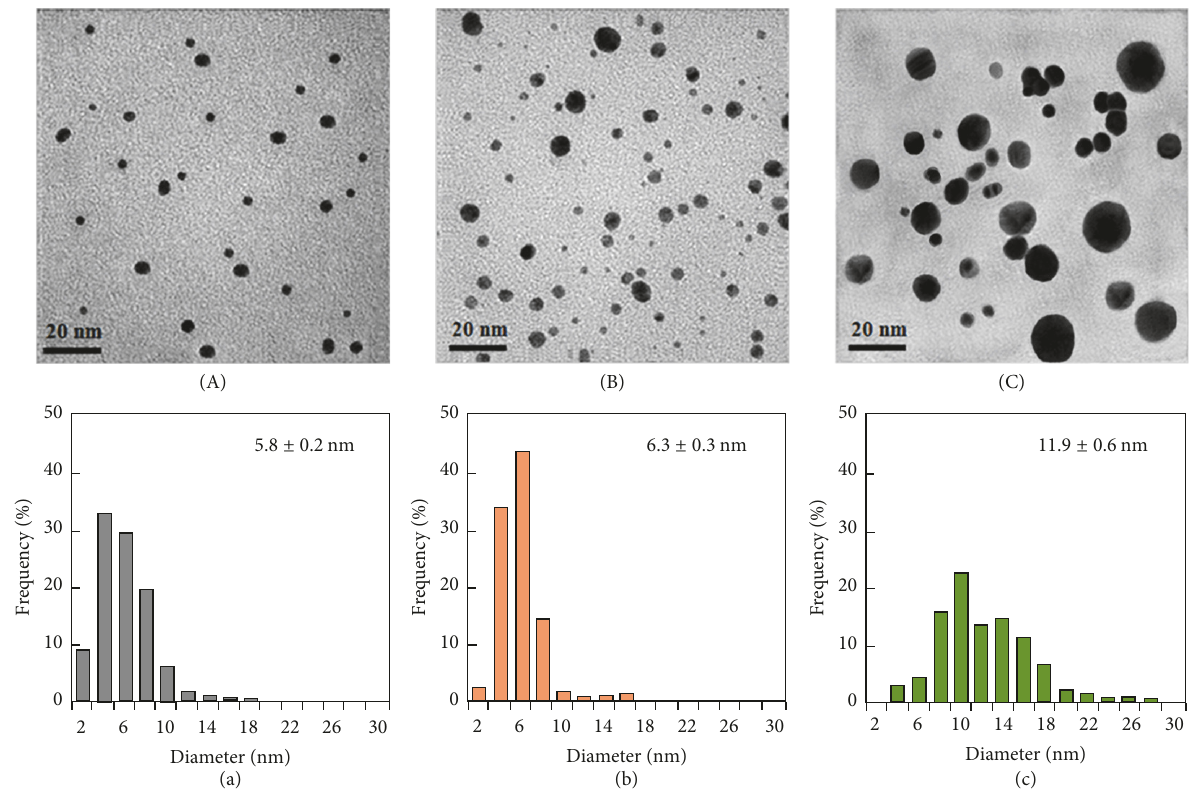
Figure 4: TEM images and size distribution histograms of AuNPs/dextran at various Au 3+ concentrations: 0.5 (A, a), 1.0 (B, b), and 2.0 mM (C, c).